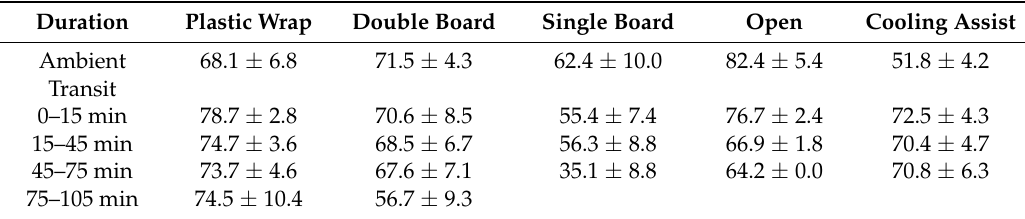
Table 4. Mean representative relative humidity (RH*, %) every 15 or 30-min during transit under five trailer configurations found in commercial broiler